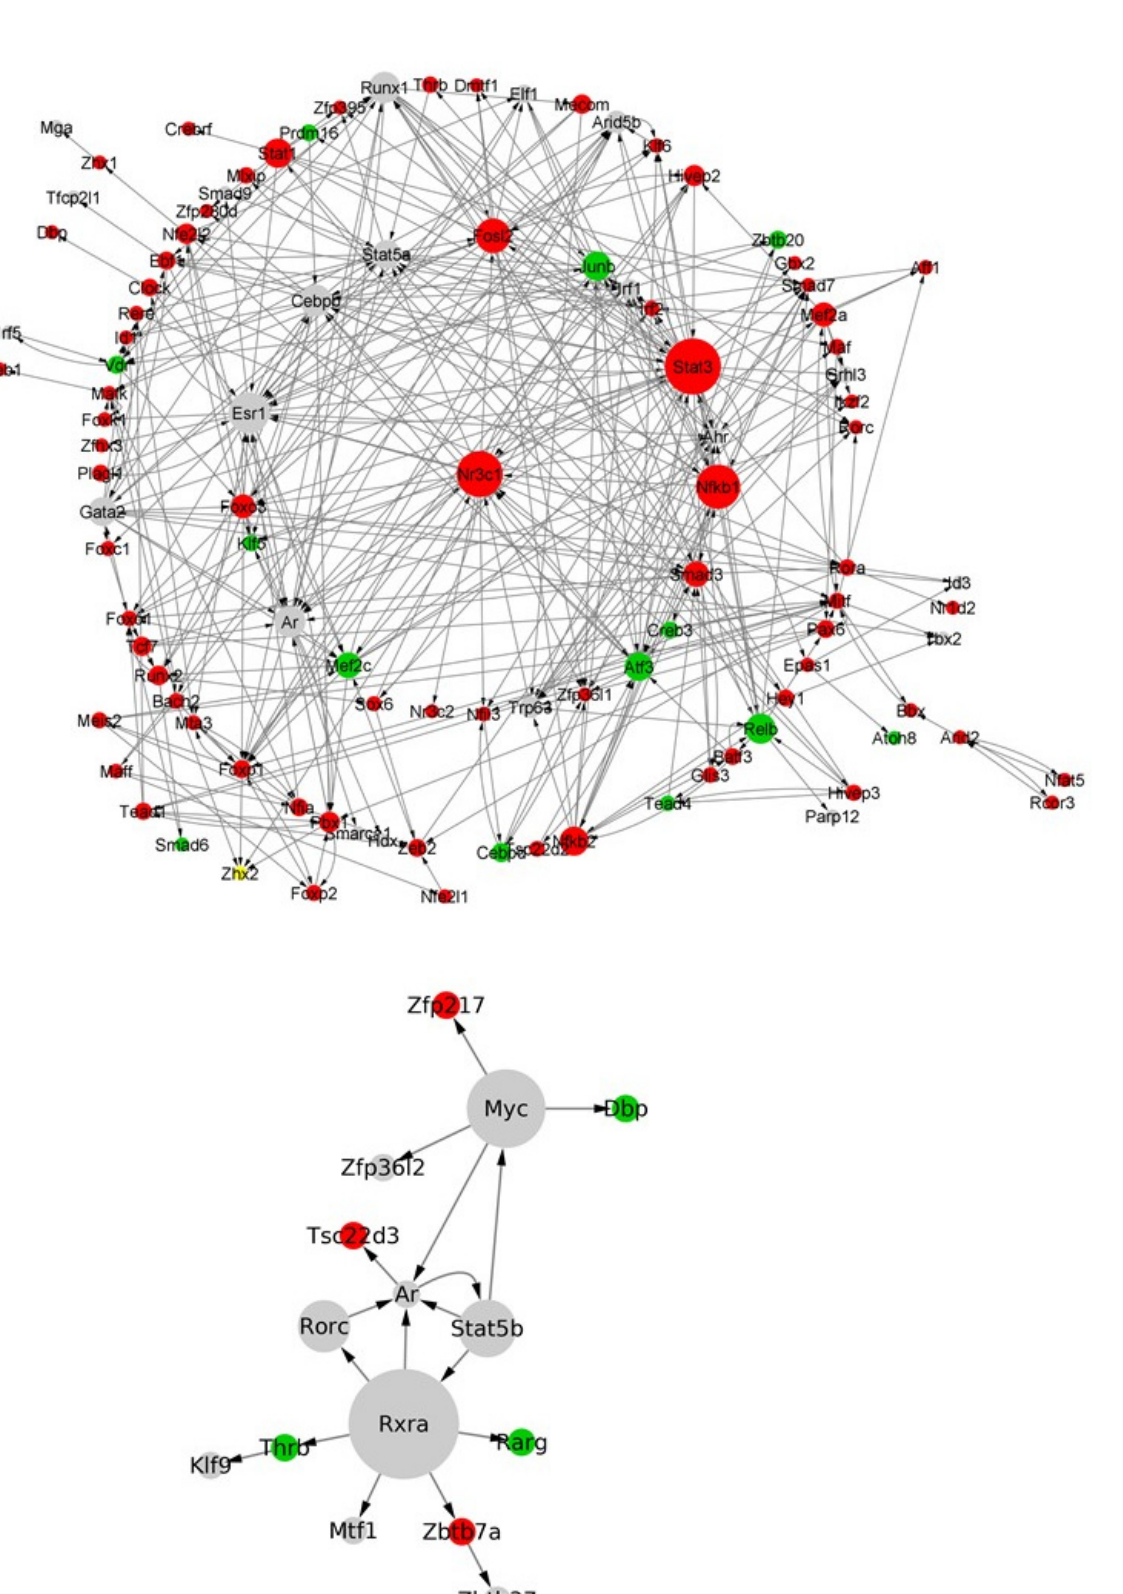
Figure 8. Reconstructed gene regulatory networks under inflammatory conditions. TF-TF regulatory network at ( A ) 24-h and ( B ) 72-h time points. Color legend represents differential accessibility of the TFs (green: upregulated; red: downregulated; grey: not differentially